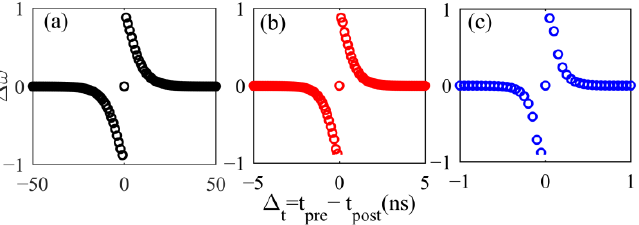
Figure 7. STDP curve at different time scales (a)